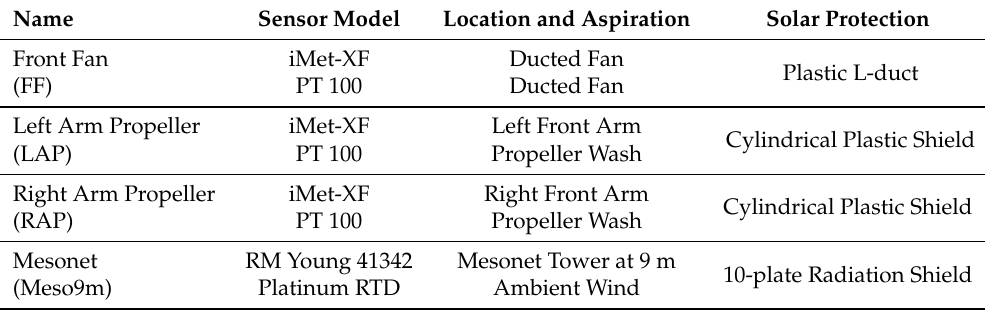
Table 1. Summary of temperature measurement